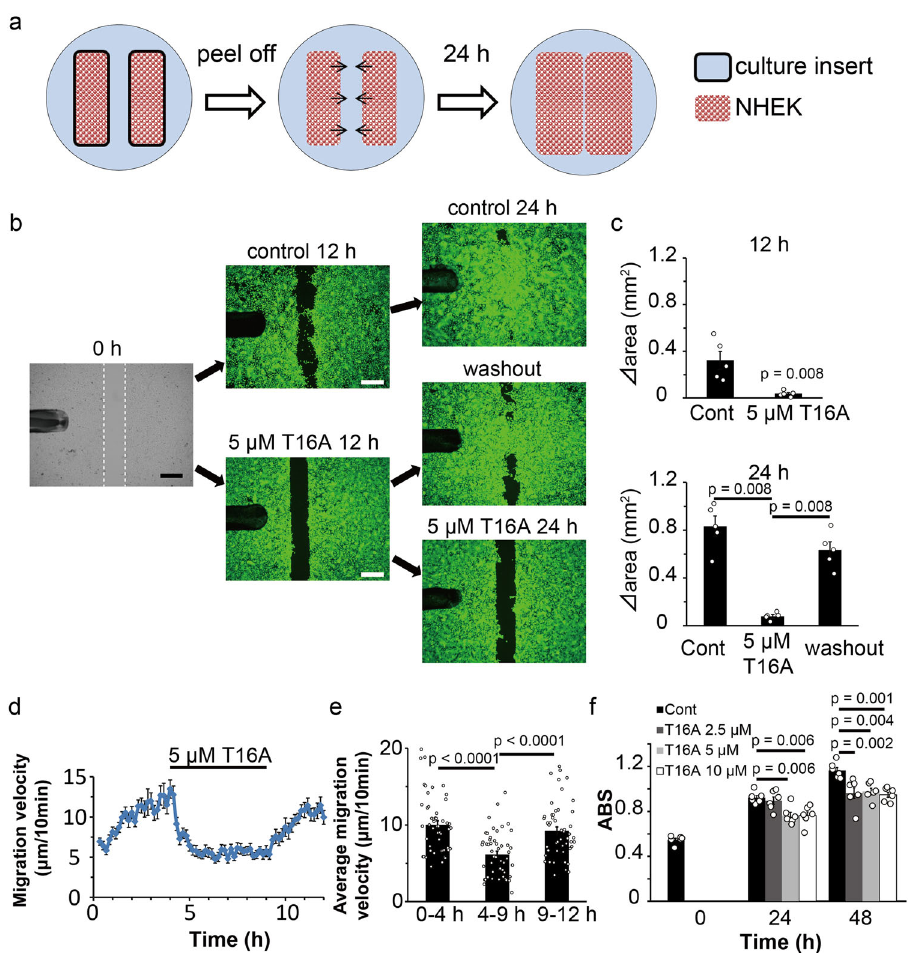
Fig. 5 Effects of an ANO1 inhibitor on cell migration/proliferation in the culture insert assay. a Schematic image of culture insert assay. b Culture insert assay in medium with or without 5 μ M T16A. Bright- fi eld at 0 h and calcein staining at 24 h. White dotted lines at 0 h indicate the borders of the cells. Washout indicates the change of medium from T16A-containing medium to control medium at 12 h. Scale bars indicate 500 μ m. c Measurements of increased areas ( Δ area) at 12 or 24 h in the medium with or without 5 μ M T16A. Data represent means ± SEM ( N = 5). Statistical signi fi cance was determined with a Mann – Whitney test. d Migration velocity of NHEKs with or without 5 μ M T16A in culture insert assay. Data represent means ± SEM ( N = 50). e Average migration velocity from ( d ). Each column indicates the average velocity during the indicated time period. Data represent means ± SEM ( N = 50). Statistical signi fi cance was determined with a Mann – Whitney test. f MTT assay of NHEKs cultured in the indicated medium. ABS indicates absorbance. Data represent means ± SEM ( N = 6). Statistical signi fi cance was determined with the one-way ANOVA followed by Dunnett